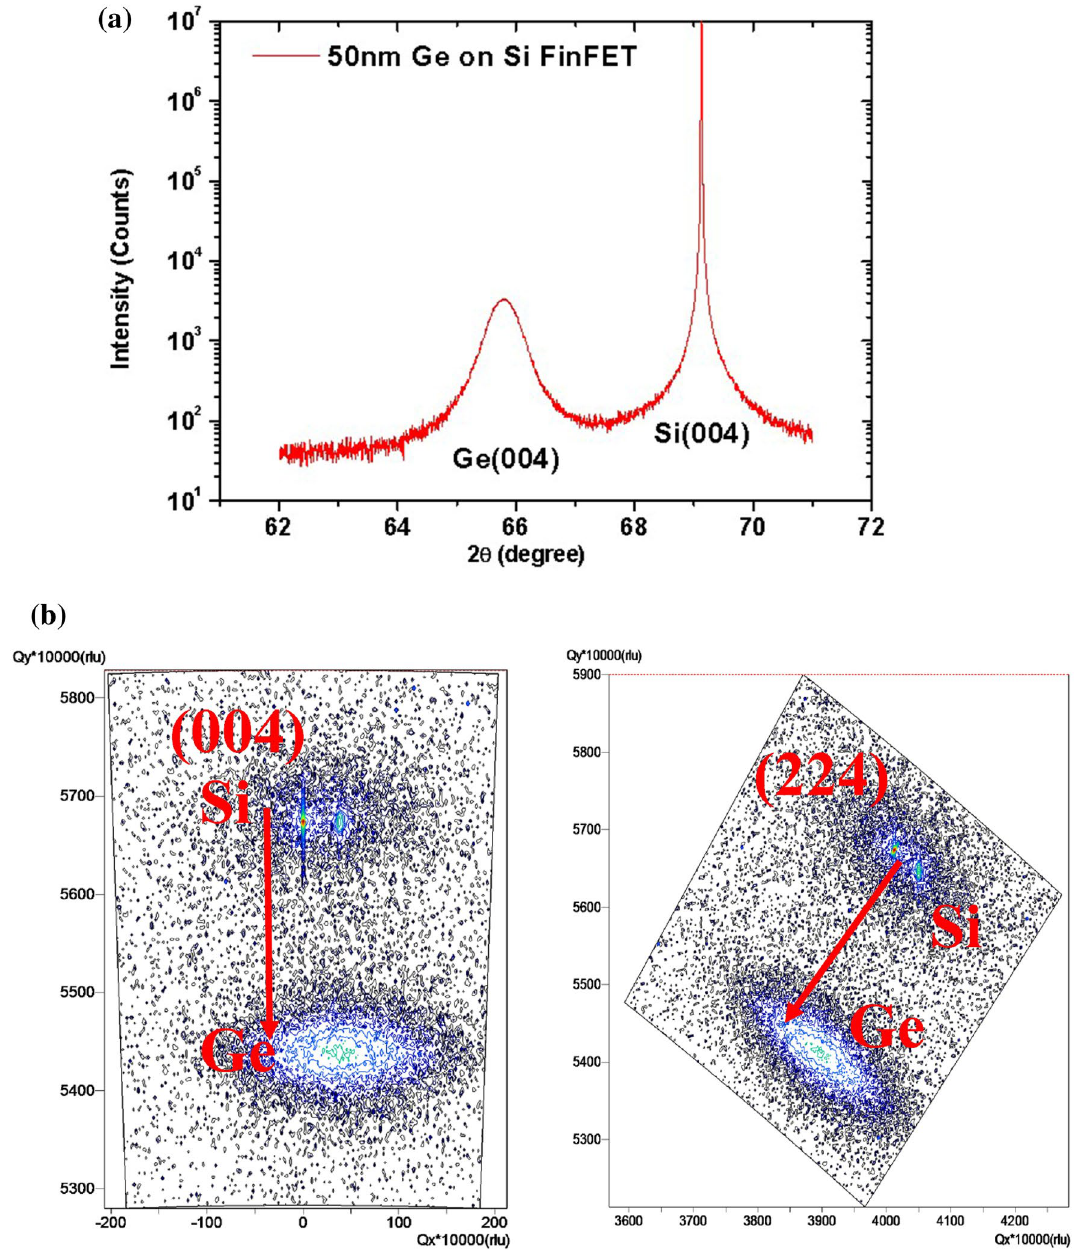
Figure 2. ( a ) XRD analysis and reciprocal space mapping (RSM) of the formation of a relaxed single-crystalline Ge (100) layer on the wafers and ( b ) RSM pattern of the Ge/Si multilayers grown two-dimensionally on the